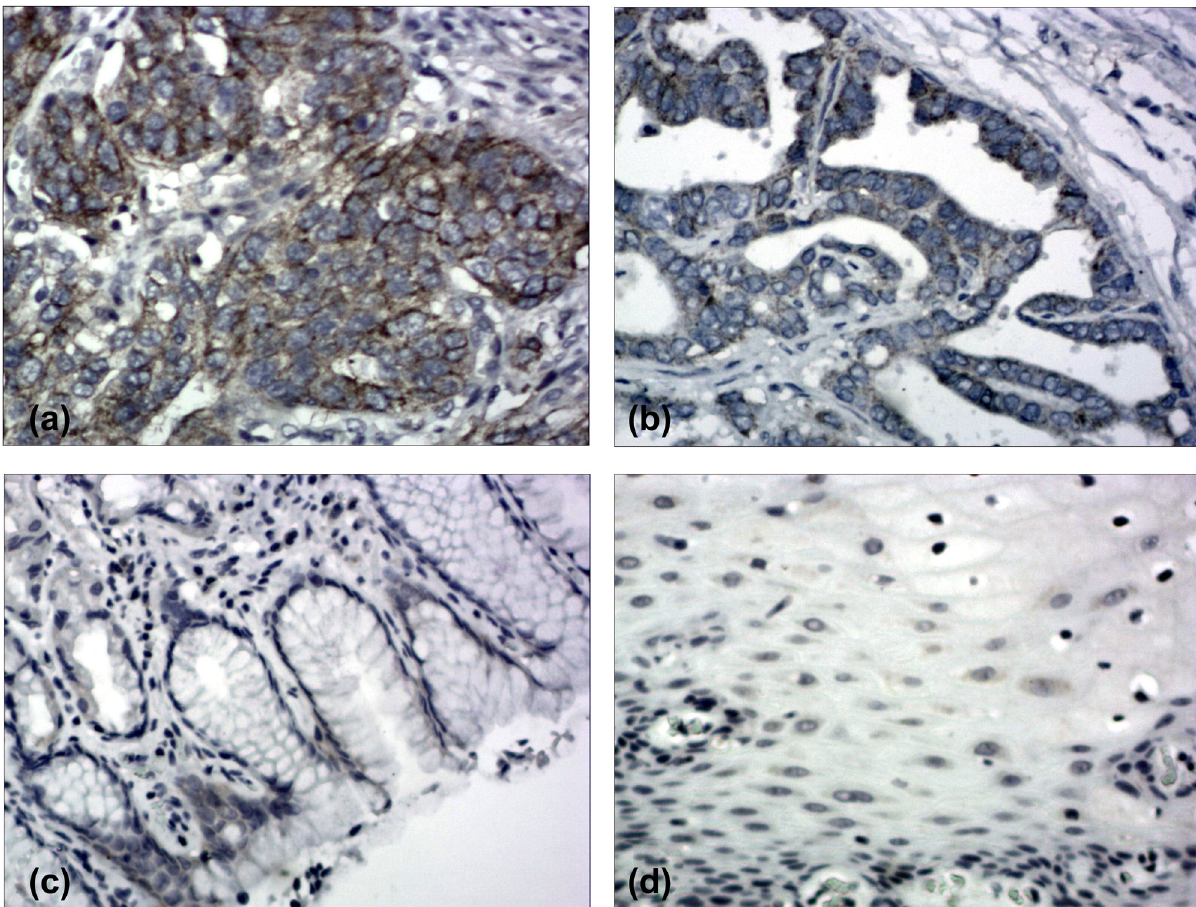
Figure 2: Immunohistochemical staining of adenocarcinoma of the esophagogastric junction ( AEG ) tissue sections demonstrating vascular endothelial growth factor ( VEGF ) ( Original magni fi cation × 200 ) . ( a ) AEG specimen with high expression of VEGF. ( b ) AEG specimen with low expression of VEGF. ( c ) The corresponding normal gastric tissue specimen with no VEGF expression ( contrast ) . ( d ) The corresponding normal esophageal tissue specimen with no VEGF expression ( contrast )